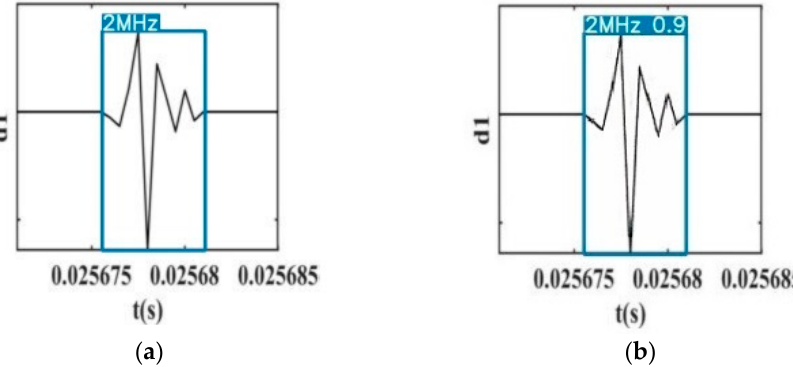
Figure 11. G-generated image detection results of YOLO v3: ( a ) test result; ( b ) detection result.